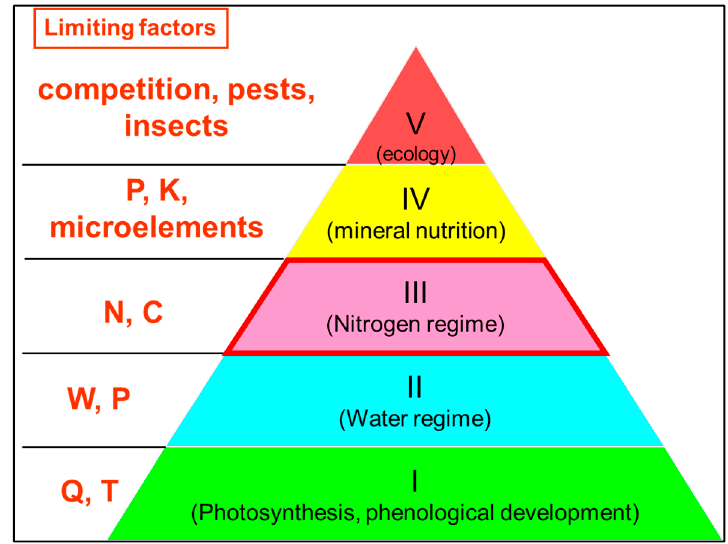
Figure 1. Generic Crop Model AGROTOOL v.3.5.: Q—solar radiation; T—temperature; W—soil moisture; P—precipitation; N—nitrogen; C—carbon; P—phosphorus; K—potassium.